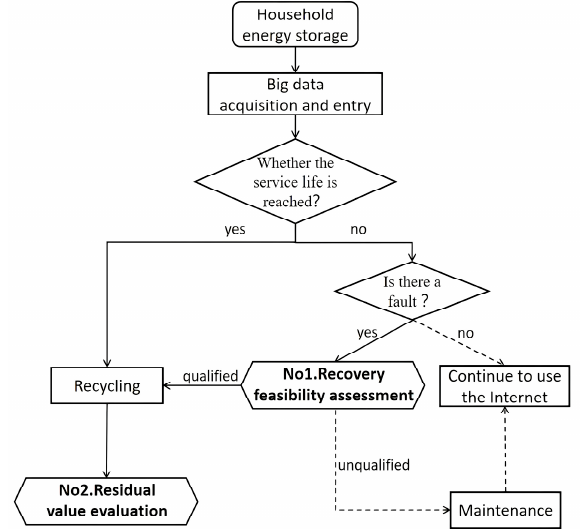
Figure 2. Status assessment process of household energy storage recycling.